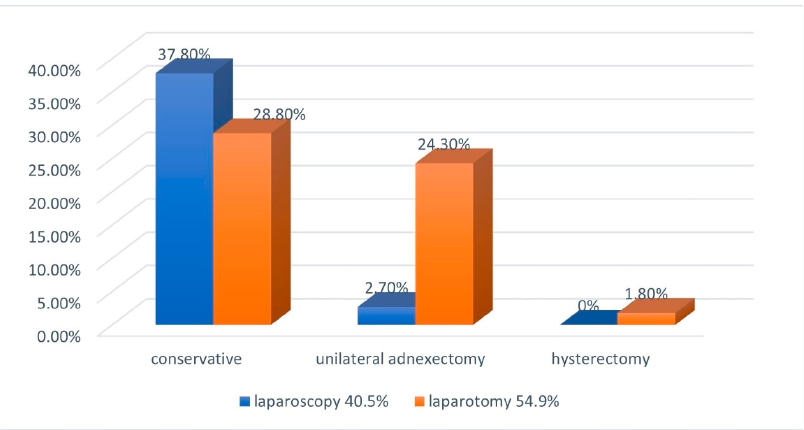
Figure 6. Treatment of ovarian pregnancies.